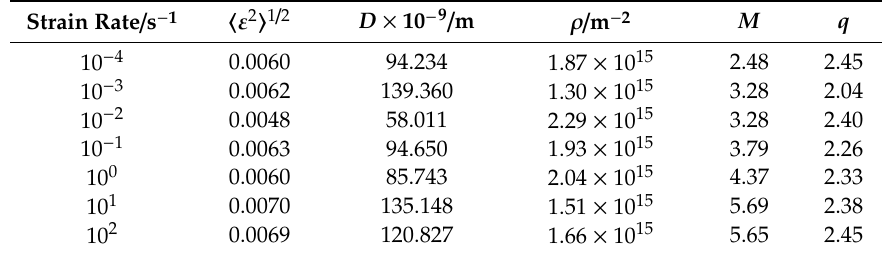
Table 1. Calculated residual microstrain, crystallite size, dislocation density, dislocation character parameter q , and dislocation arrangement parameter M at various strain